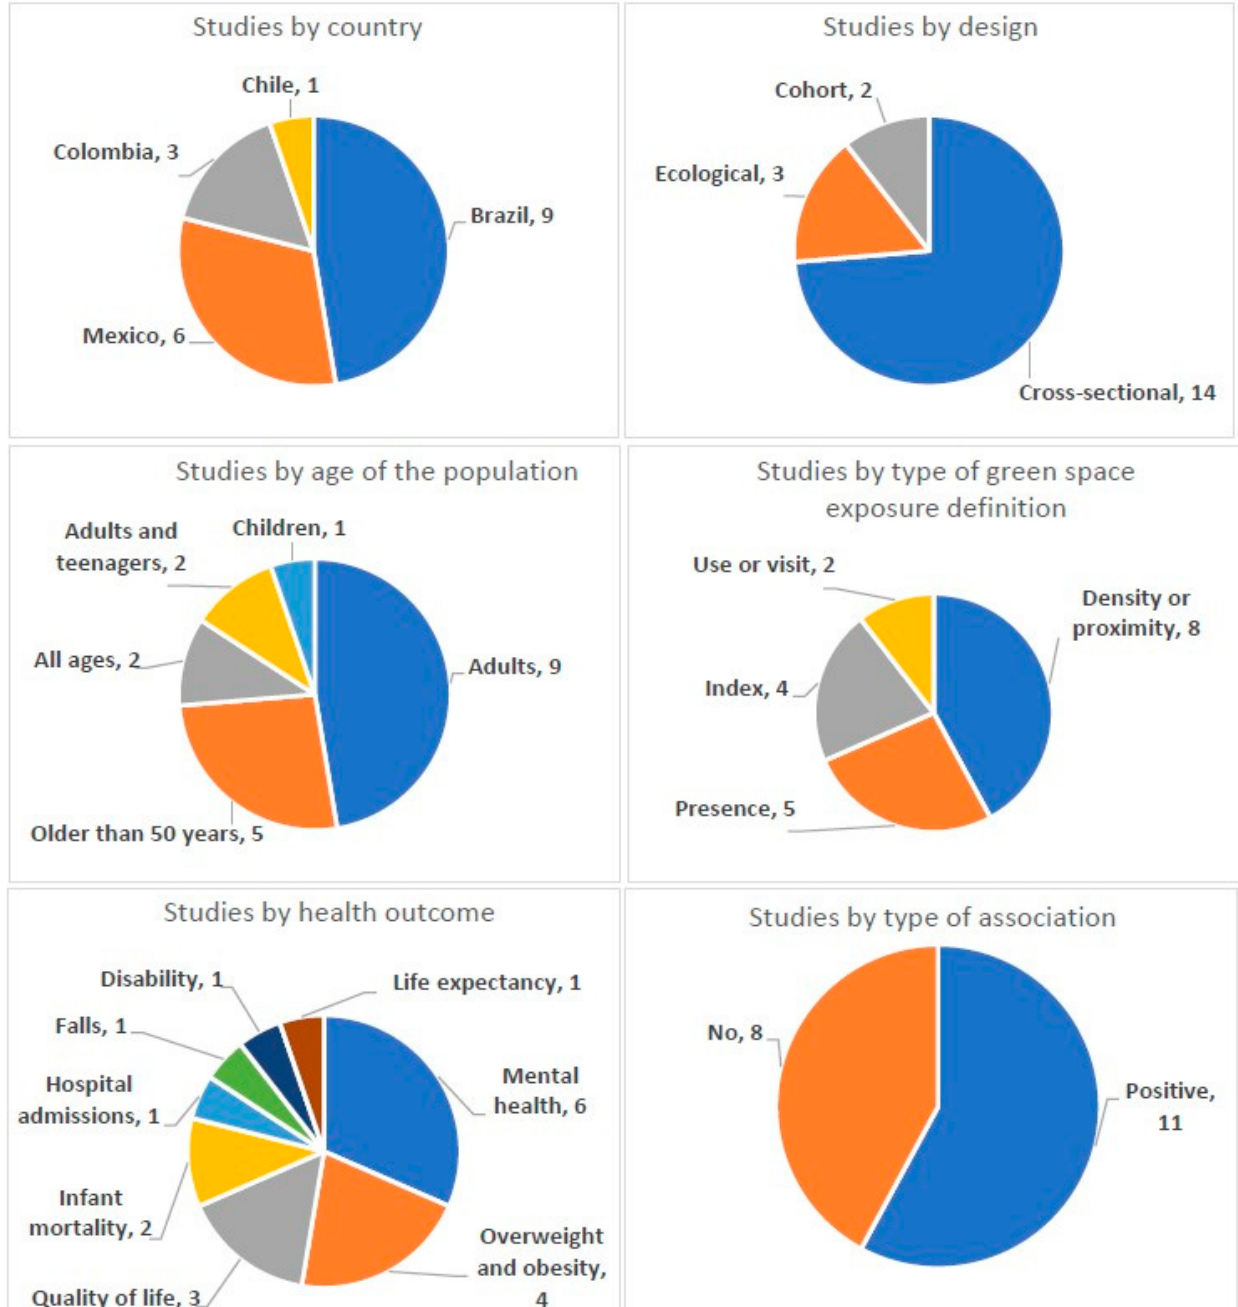
Figure 2. Summary of the studies characteristics and findings.